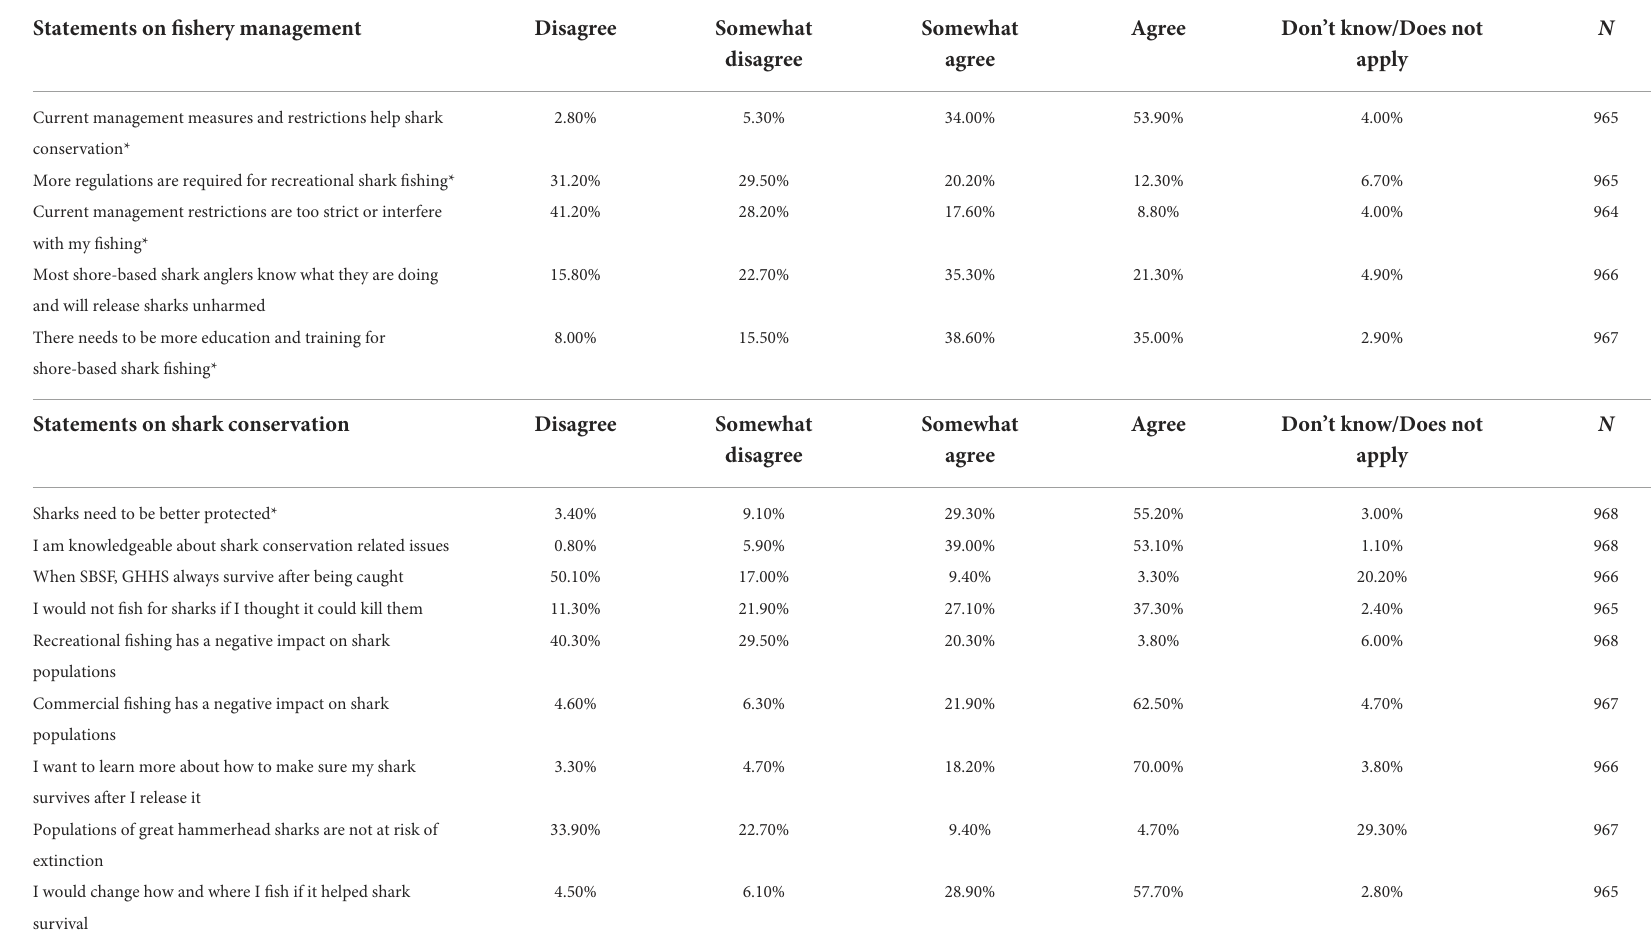
TABLE 2 Angler’s level of agreement and support toward shore-based shark fishery management and shark